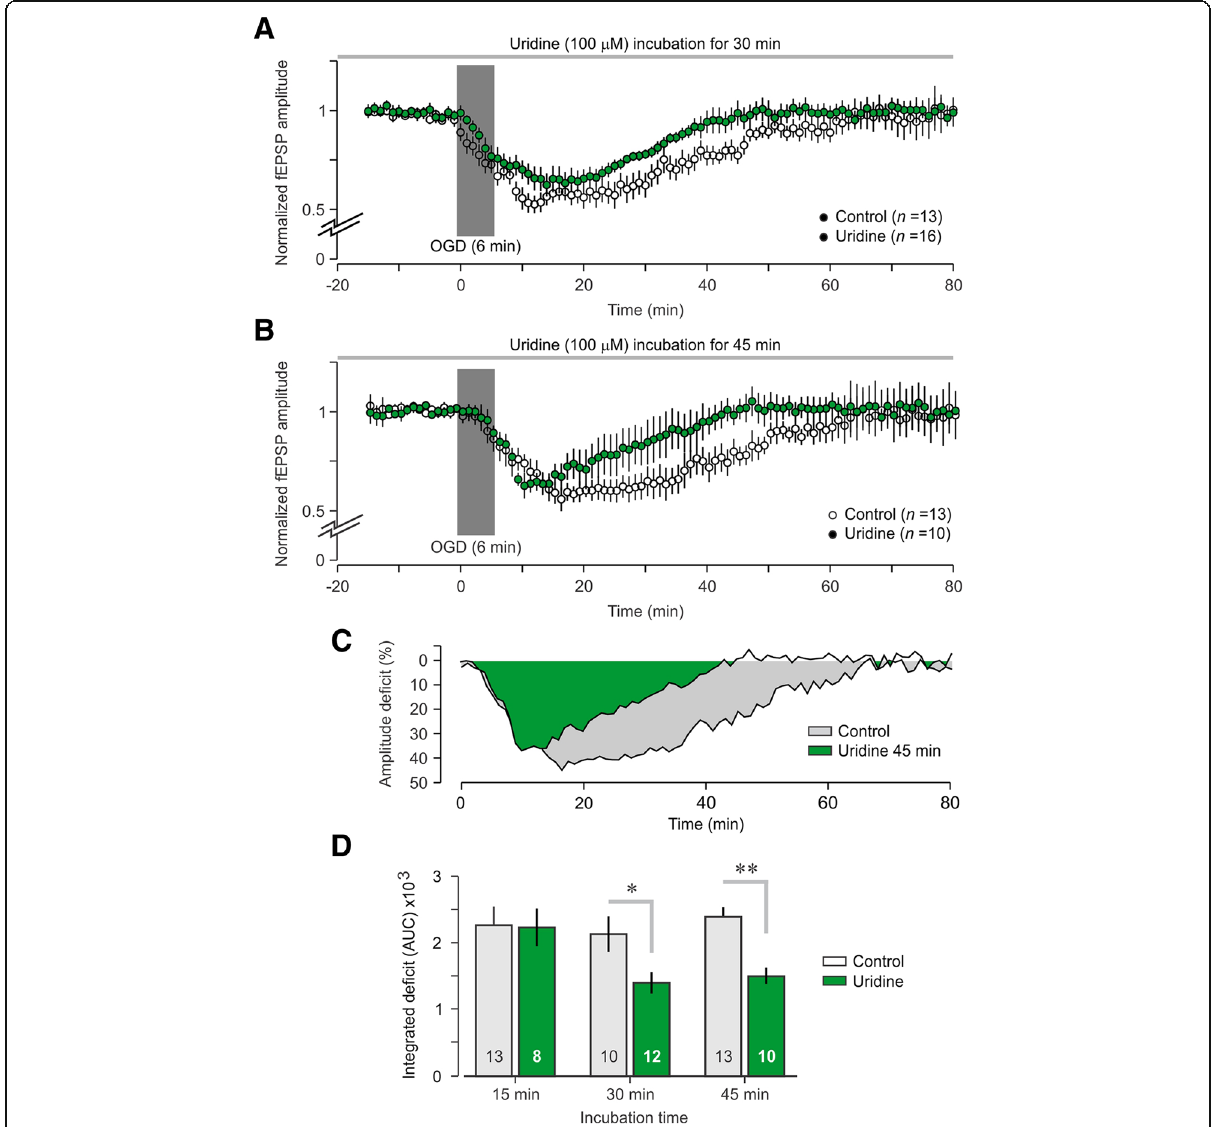
Fig. 5 Protective effect of uridine against oxygen-glucose deprivation . a Graph showing normalized fEPSP amplitudes (mean ± SEM) for brain slices that are treated in uridine (100 μ M) for 30 min before receiving an oxygen-glucose deprivation (OGD) insult (6 min). b In this set, brain slices are in uridine (100 μ M) for 45 min before receiving an OGD insult (6 min). c Plot showing the percent amplitude deficit for the 45 min uridine group compared to the untreated control group. In the uridine group, the amplitude deficit disappears by 45 min post-OGD (vs. 65 min in control), highlighting the protective action of uridine. d Graph showing the total OGD deficit, which is calculated from the percent amplitude deficit plots by taking the area-under-curve (AUC) for three different incubation periods: 15 min, 30 min, and 45 min. The short incubation (15 min) is insufficient for a protective effect against 6 min OGD, while the longer incubation periods (30 min and 45 min) significantly reduce the magnitude of the OGD-induced deficit; *, P < 0.05; **, P < 0.01 (t-test). Numbers within bars indicate number of brain slices per